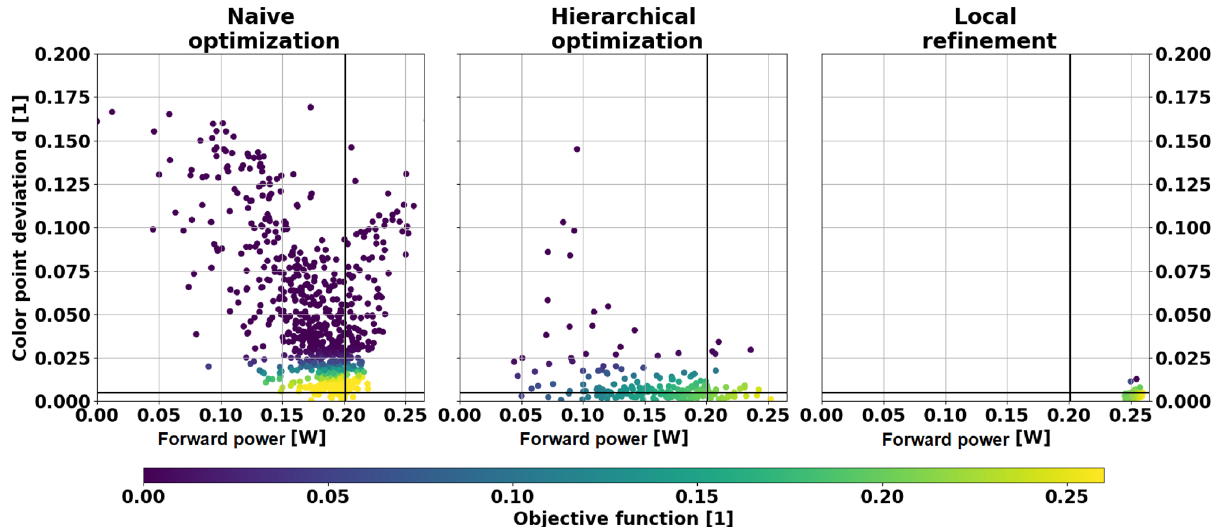
Figure 4. Color point deviation d α over power P α after joint (left, TS-EMO), hierarchical (middle, TS-SOO) and local (right, Downhill simplex) optimization for α = 25 ◦ . The horizontal black lines denote the color point deviation of 0.005 points, where W ( 0.005 ) = 0.99 holds. The vertical black lines denote the power of the reference design without multi-layer thin film. For each sample in these plots, the color map reflects the objective function values obtained by Eq.